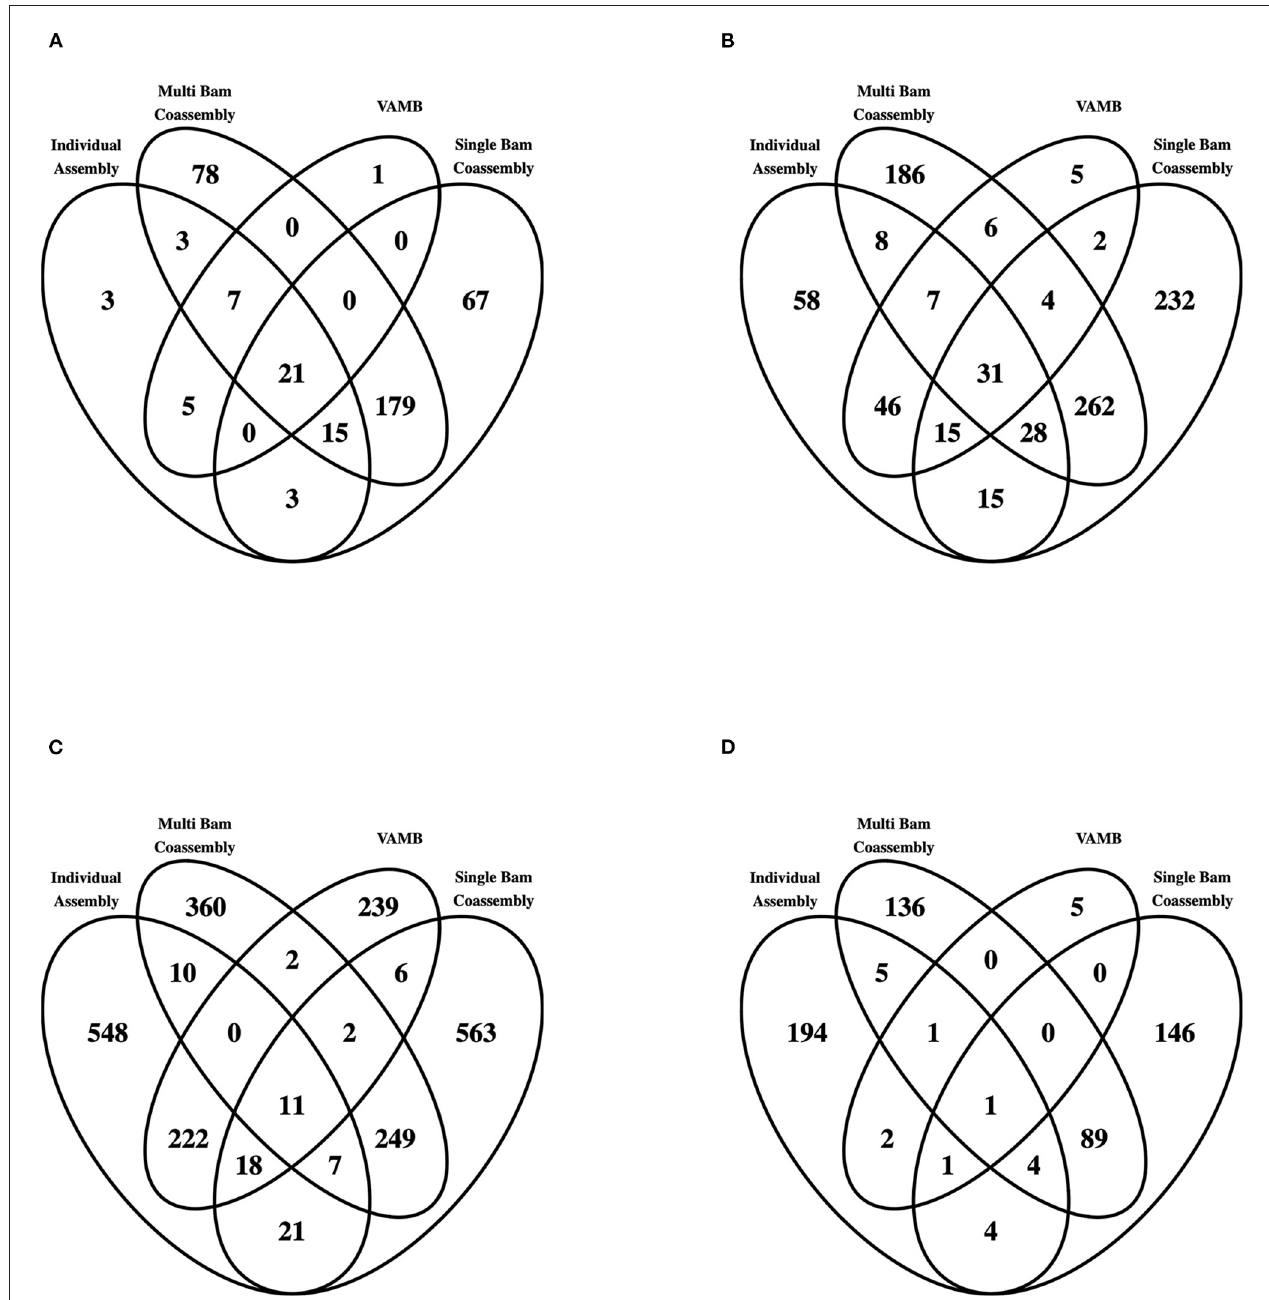
FIGURE 4 | MAG recovery across all four workflows employed in this study, conditioned by genome quality. The entire set of 9,709 MAGs was categorised by genome quality level, and within each quality genome level further categorised by the workflow of origin observed with each secondary cluster. Venn diagrams showing interrelationships are shown here for (A) pHQ (putative high quality); (B) MQ (medium quality); (C) LQ (low quality) and (D) UC